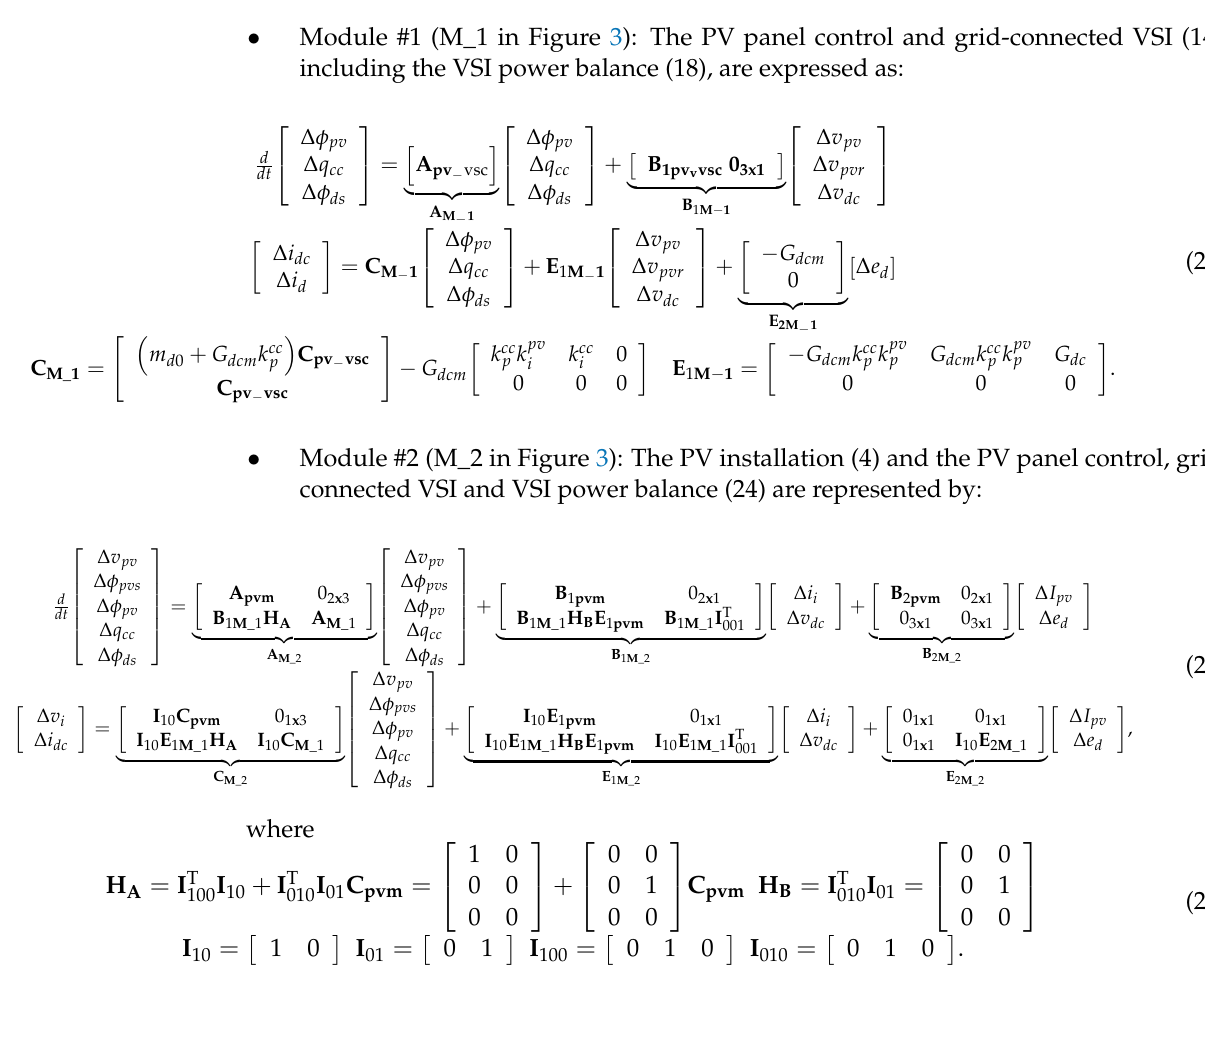
Figure 3. The qZSI-PV system block diagram (the symbol ∆ is